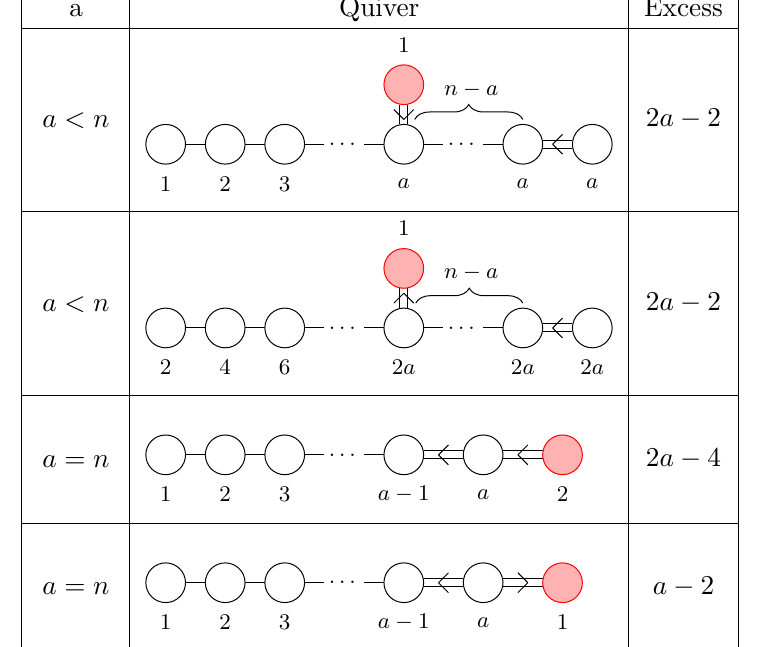
Table 30 . Exotic minimally unbalanced quivers with G = Sp(2 n ) and an extra double laced edge. (cid:15) Operators in the adjoint of the isometry group G (corresponding to the